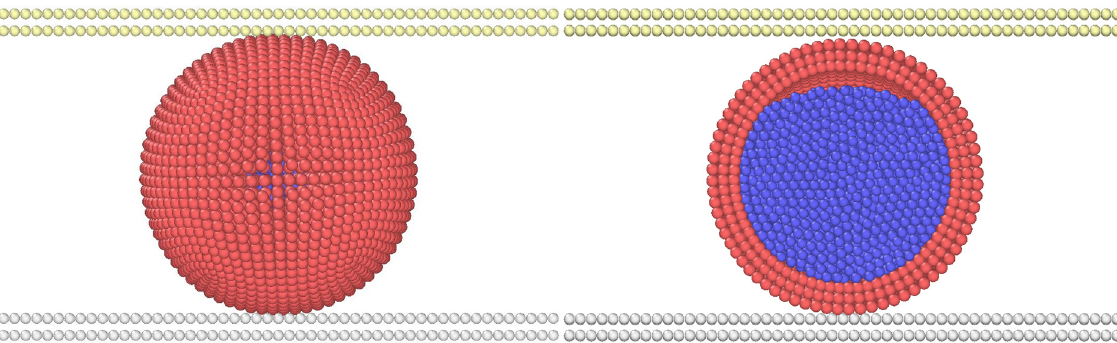
Figure 3. Initial simulation geometry.